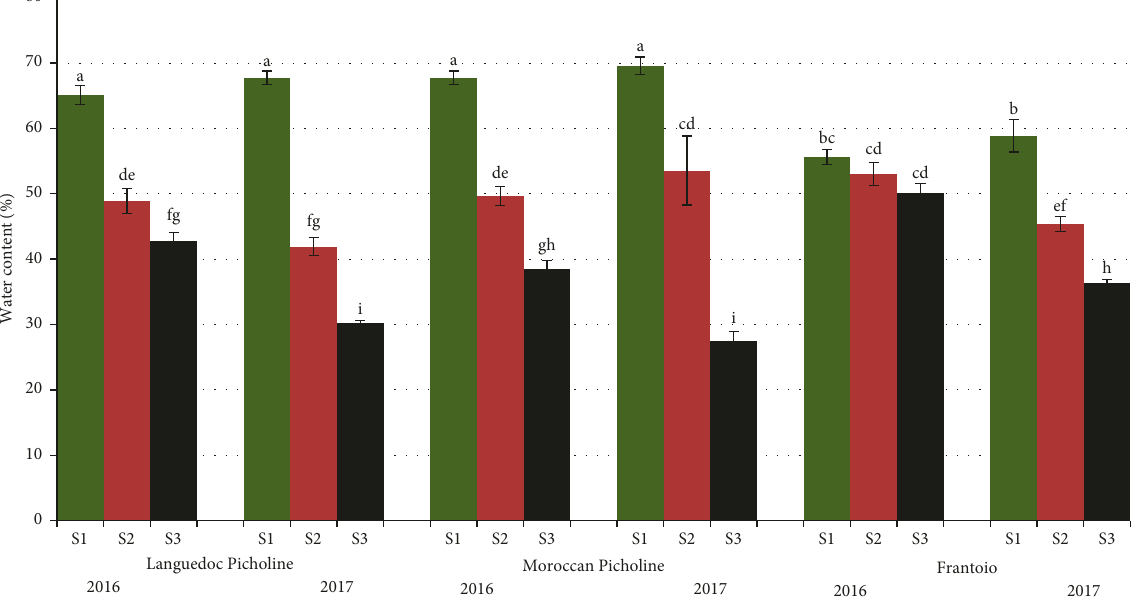
Figure 5: Water contents (% FW) of different olive cultivars grown in the Errachidia region (East Morocco) at different stages of maturity (S1: green; S2: purple; S3: black). Values are means ± standard deviation (SD) of three replications. Data followed by different letters are significantly different from each other ( P < 0 . 05) according to LSD test.